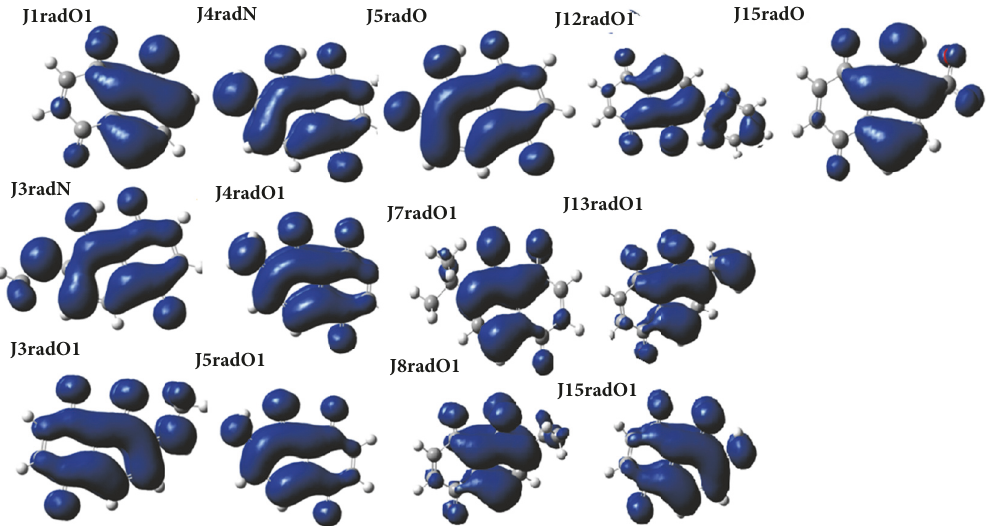
Figure 2: Plots of spin density for various hydrogen atom-abstracted radicals of juglone and selected